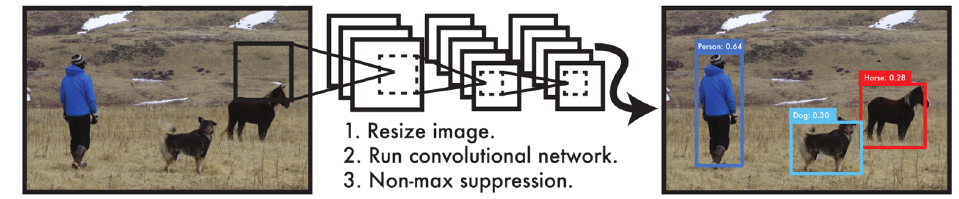
Figure 5. The framework of the YOLO algorithm [29].